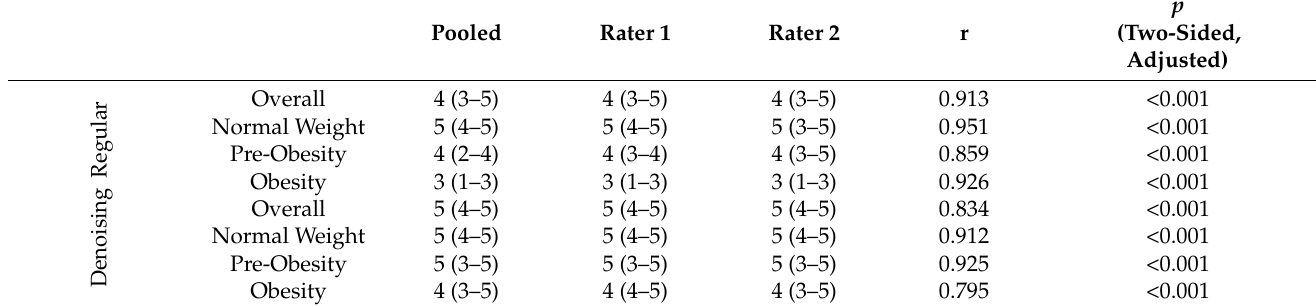
Table 4. Diagnostic